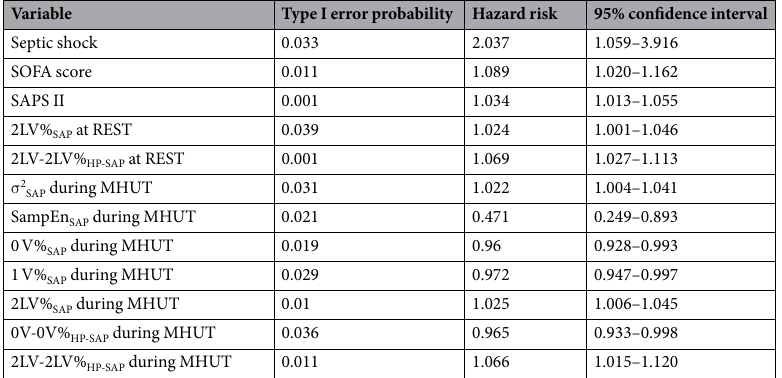
Table 2. Results of univariate Cox regression analysis. SOFA = sepsi-related organ failure assessment; SAPS = simplified acute physiology score; REST = at rest in supine position; MHUT = modified head-up tilt; HP = heart period; SAP = systolic arterial pressure; σ 2 SAP = variance of SAP; SampEn SAP = sample entropy of SAP; 0 V% SAP , 1 V% SAP and 2LV% SAP = percentage of 0 V, 1 V, and 2LV patterns respectively as detected by univariate symbolic analysis of SAP; 0V-0V% HP-SAP and 2LV-2LV% HP-SAP = percentage of 0V-0V and 2LV-2LV patterns respectively as detected by bivariate symbolic analysis of HP and